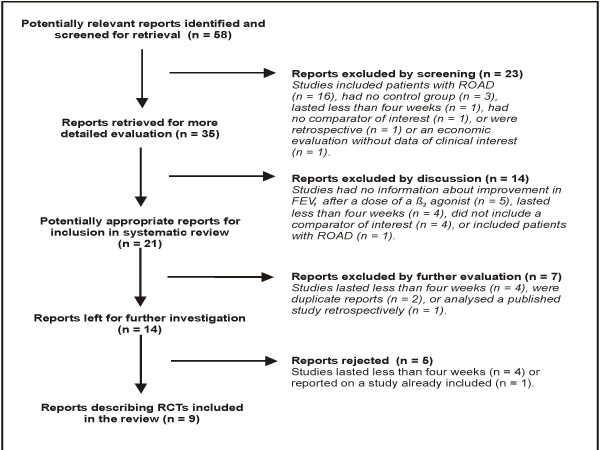
Flow diagram of RCT screening and selection procedure. Process through which reports were selected from those potentially relevant. RCT = randomised controlled trial; ROAD = reversible obstructive airways disease; FEV1 = forced expiratory volume in one second.